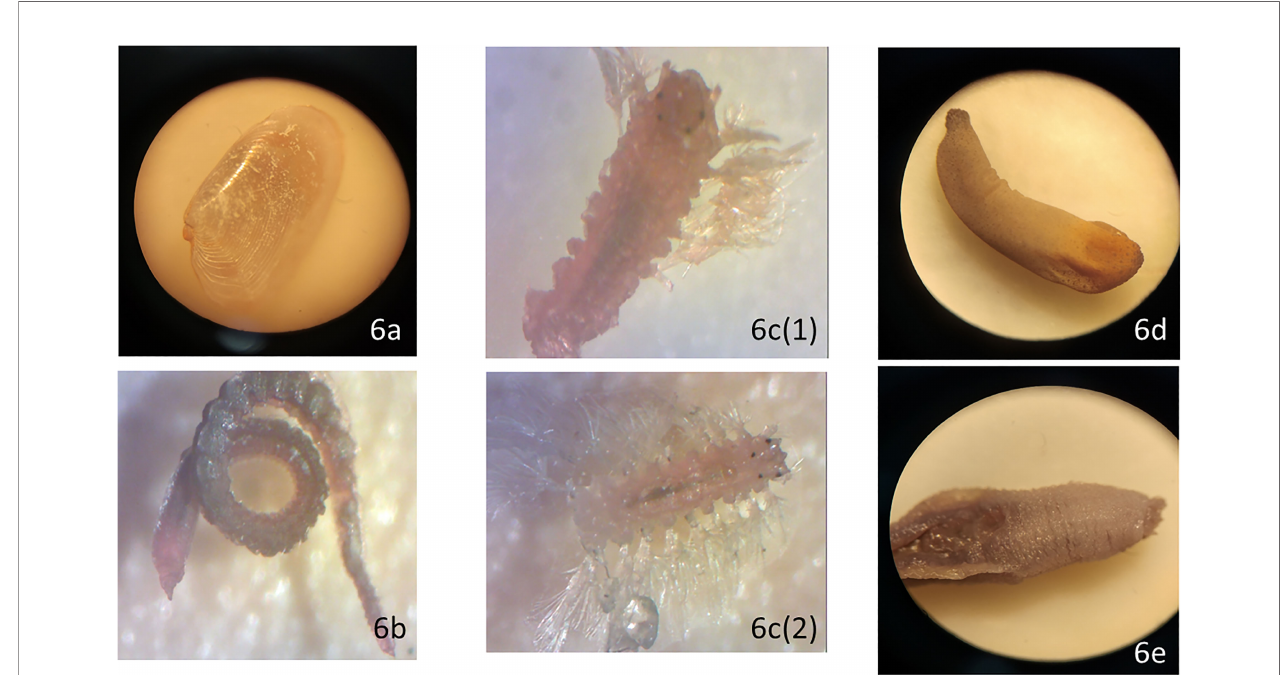
FIGURE 6 | Microscopic images of macrobenthos: (A) bivalve, (B) capitellid, (C) hesionid, (D) peanut worm, and (E)